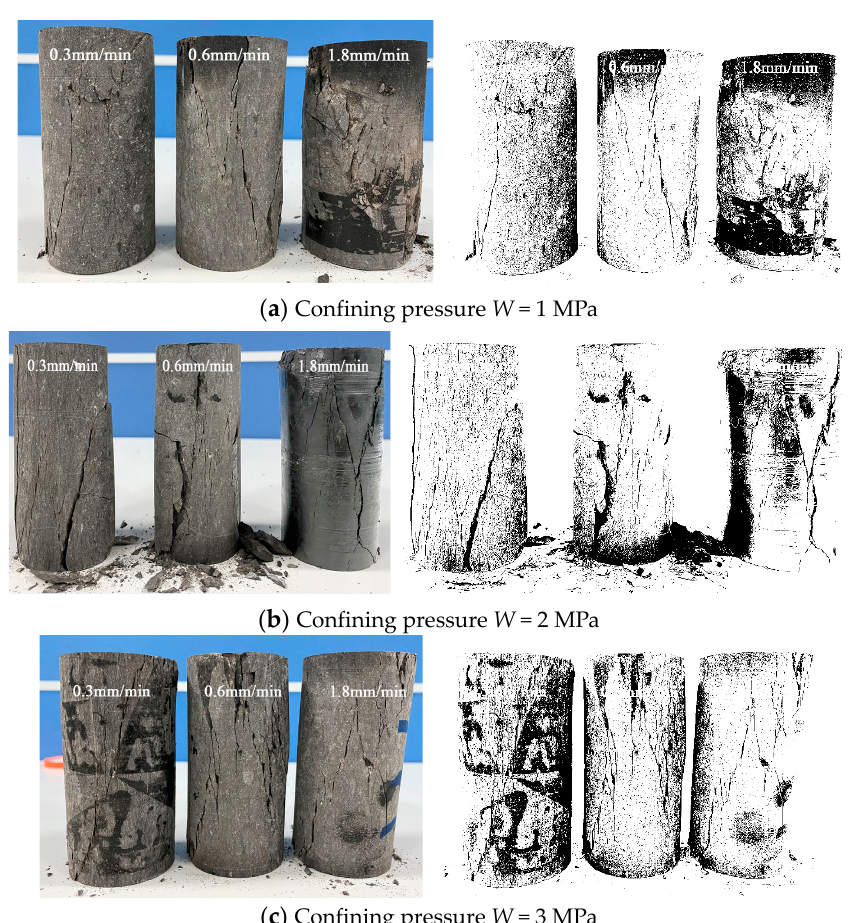
Figure 6. Failure characteristics and binary treatment of specimens.